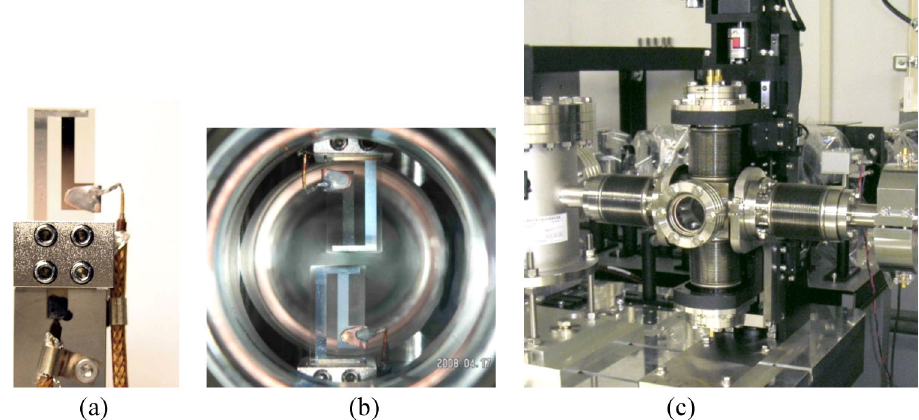
FIG. 6. Photographs: (a) diamond-based detector on the holder, (b) configuration of the detectors in the vacuum chamber, and (c) beam halo monitor installed at the SCSS test accelerator.